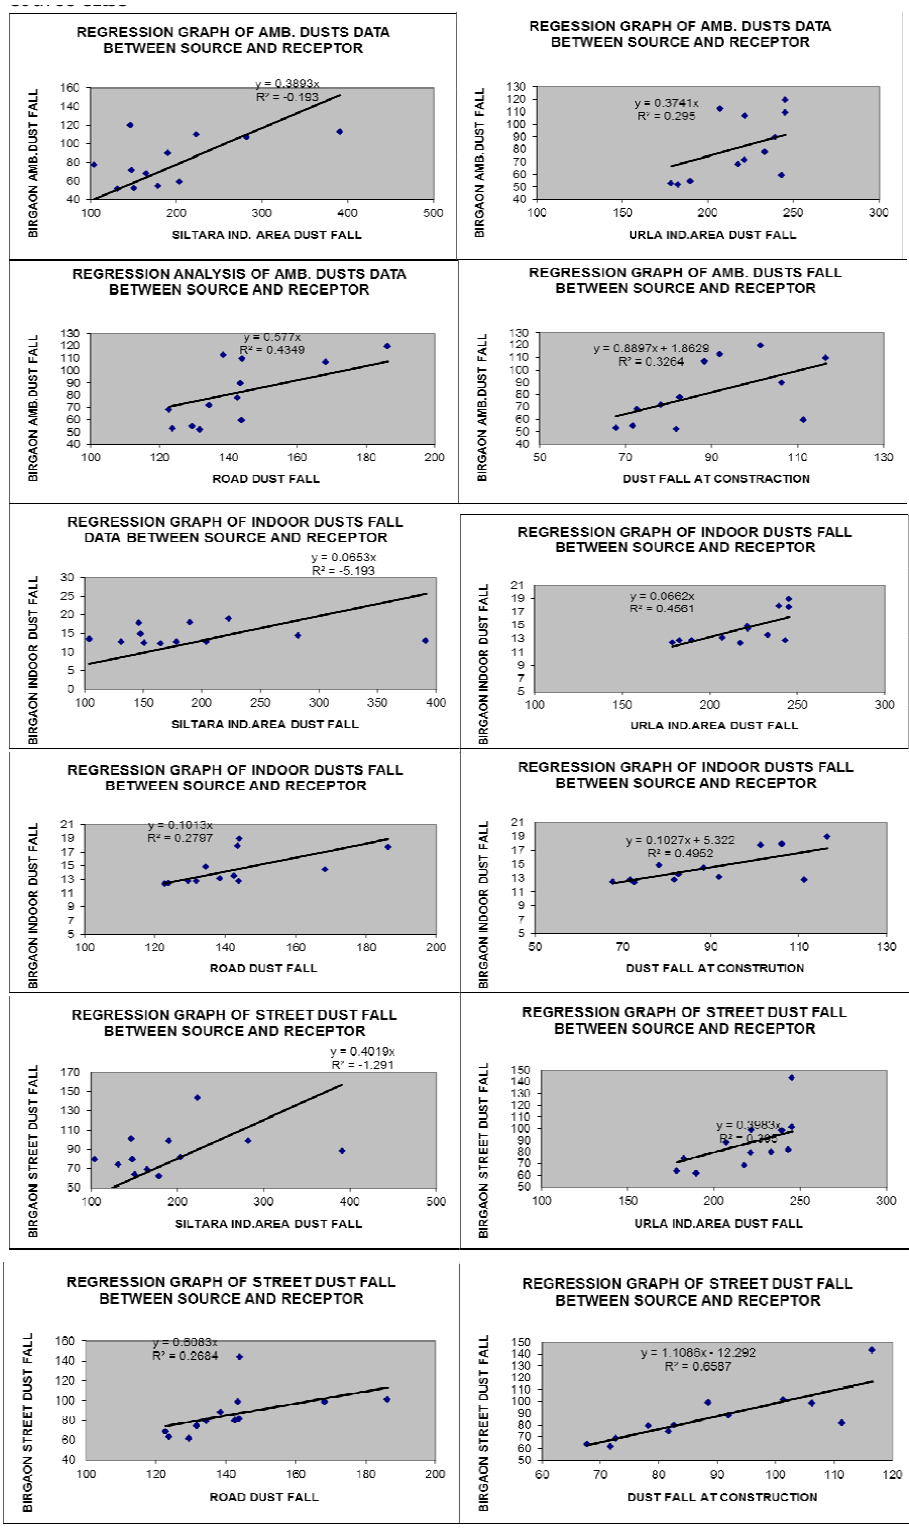
Fig: 2 Regression analysis between selected dust fallout receptors and dust fallout at identified source sites